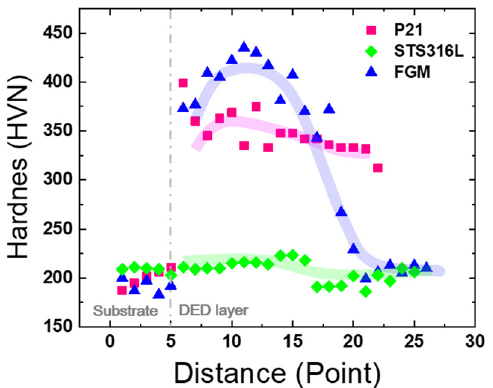
Figure 14. Micro-hardness measurement depending on location of P21, STS316L and FGM DED